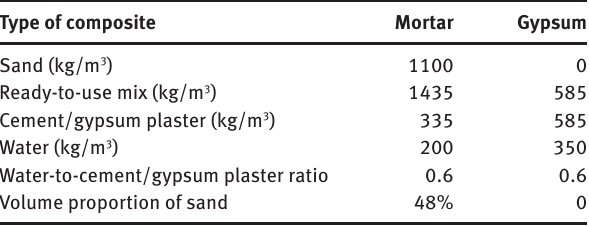
Table 1: Constituents of composites.